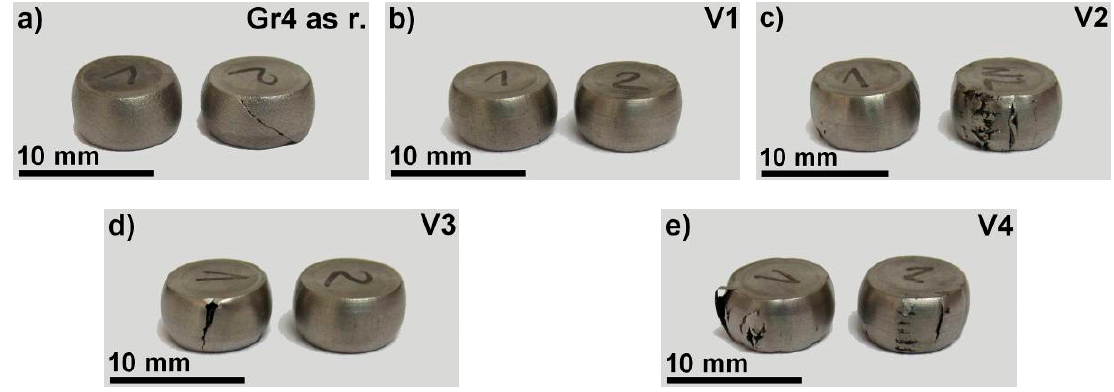
Figure 13. Macroscopic view of the samples after the uniaxial compression tests: ( a ) Ti Gr4, as received state, ( b ) variant V1, ( c ) variant V2, ( d ) variant V3, ( e ) variant V4.